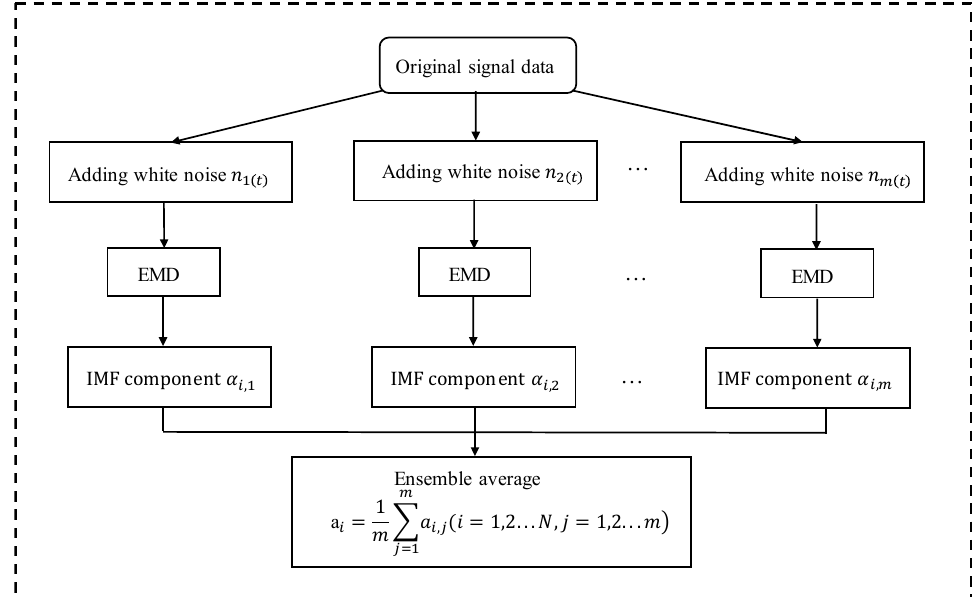
Figure 1. The procedure for EEMD.